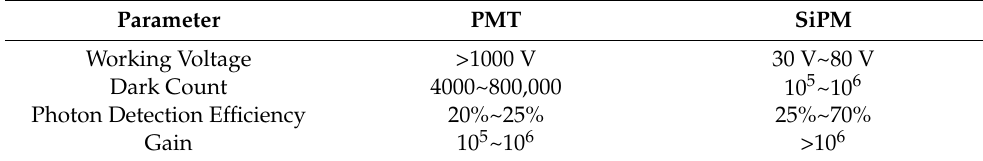
Table 1. Key parameters of PMT and